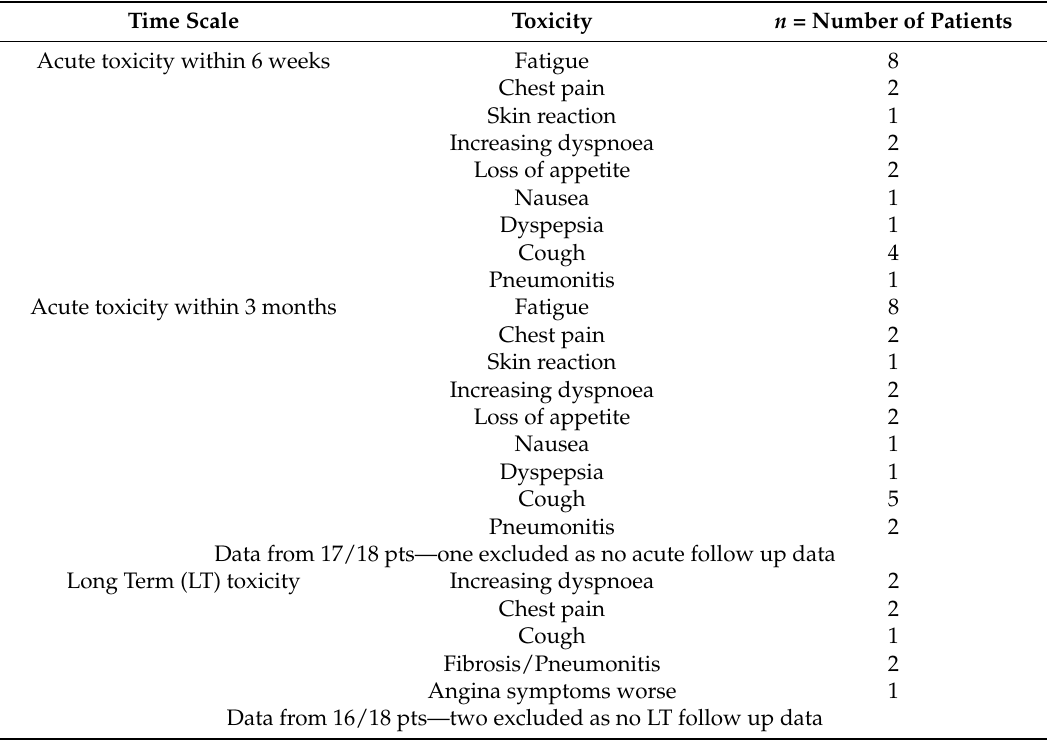
Table 2. CTCAE v3 grade 1–2 acute and long term (LT)